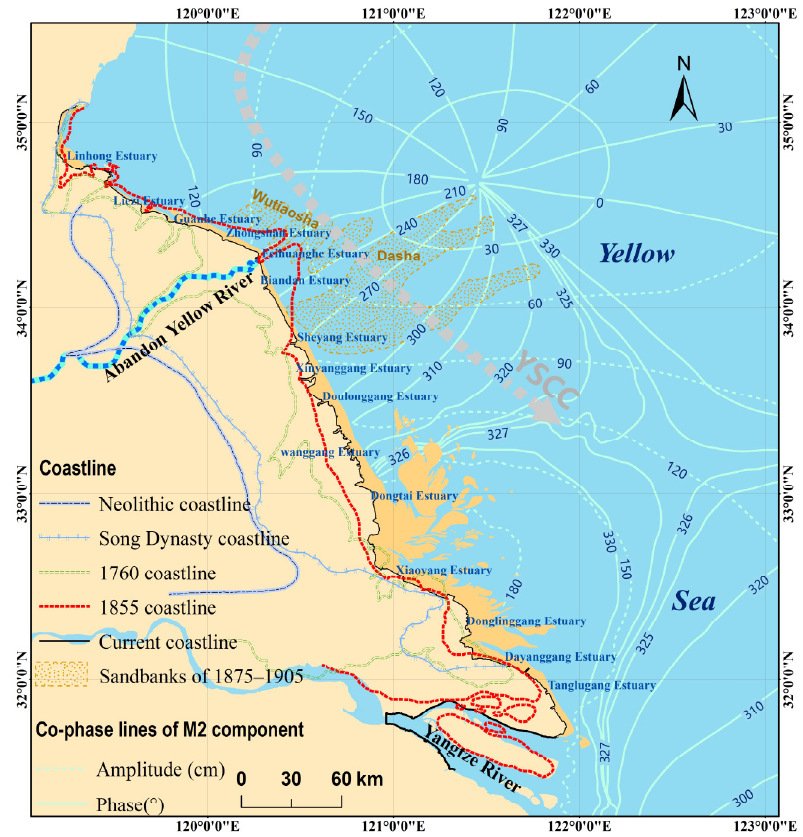
Figure 11. Historical shoreline evolution and tidal wave system. The historical shorelines are collected from Zhang 1985 [41]; subwater sandbanks are collected from Zhou et al. 2014 [6]; co-phase lines of M 2 component in southern yellow sea are collected from Xu et al. 2016 [16].